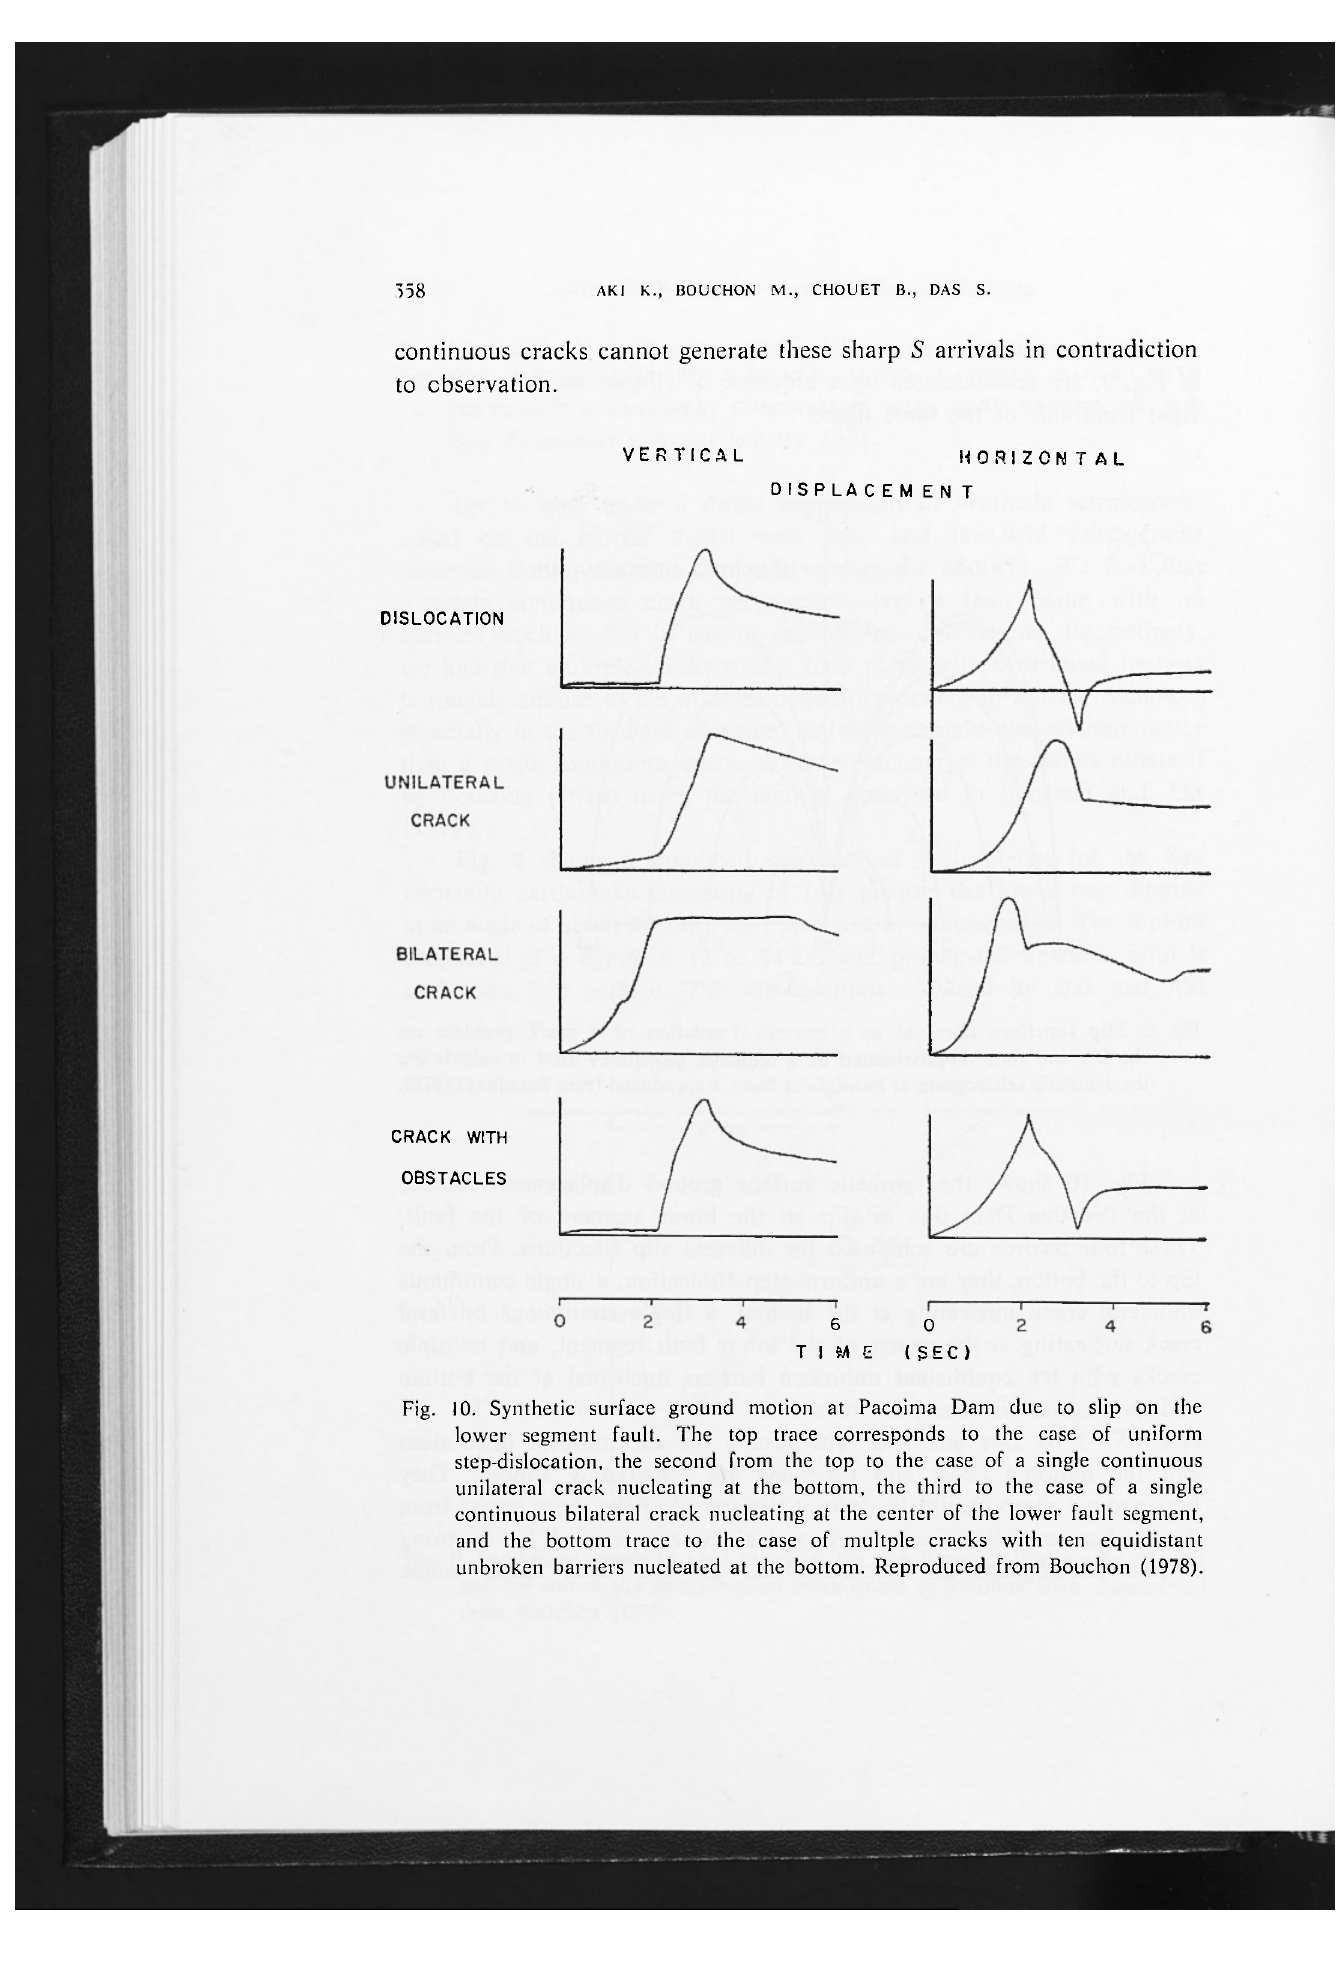
Fig. 10. Synthetic surface ground motion at Pacoima Dam due to slip on the lower segment fault. The top trace corresponds to the case of uniform step-dislocation, the second from the top to the case of a single continuous unilateral crack nucleating at the bottom, the third to the case of a single continuous bilateral crack nucleating at the center of the lower fault segment, and the bottom trace to the case of multple cracks with ten equidistant unbroken barriers nucleated at the bottom. Reproduced from Bouchon